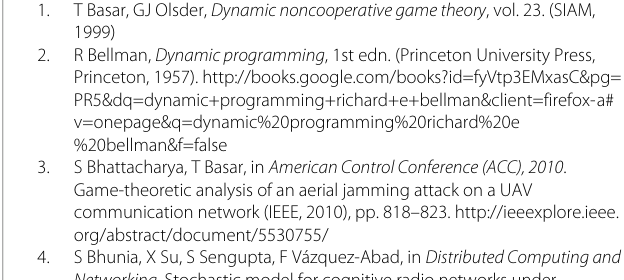
Fig. 3 Comparison of empirical CDF for relative error between the game with L = 1 and the game with L = A + Br , using Eq. 50. For the game with L = 1, we used the hybrid approach. For the case when L = A + Br , we used the optimization approach ( bluecontinuouslines ) and the ˆ (cid:12) v approximation ( reddashedlines ). It is possible to see that in both cases, the CDF of the error shows that more than 90% of the cases are below a relative error of ζ = 1%. ( a ) Evader. ( b